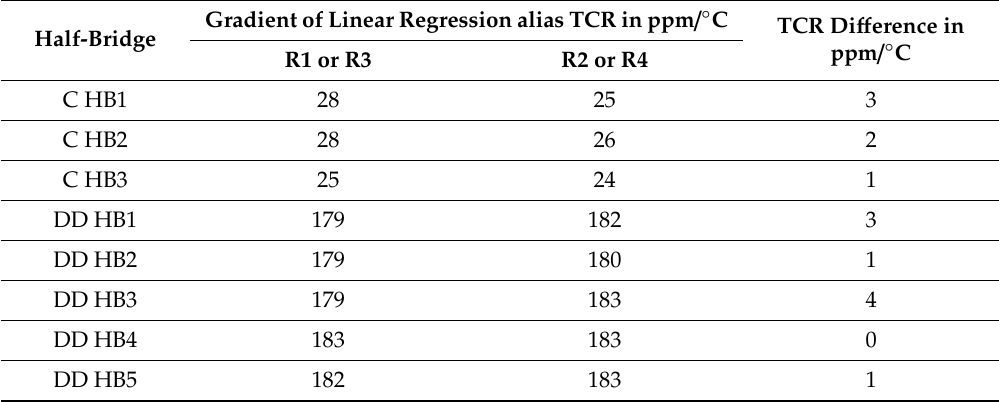
Figure 8. Temperature behaviour of two resistances forming one half-bridge. Curves are evaluated after cooling down from 100 °C to 25 °C. Results are shown for ( a ) commercial and ( b ) directly deposited strain gauges. Abbreviation C means commercial; DD stands for directly deposited. Table 1. Gradient of linear regression alias TCR and TCR di ff erences of two resistances forming one half-bridge. Measurements took place for commercial (C) and directly deposited (DD) strain